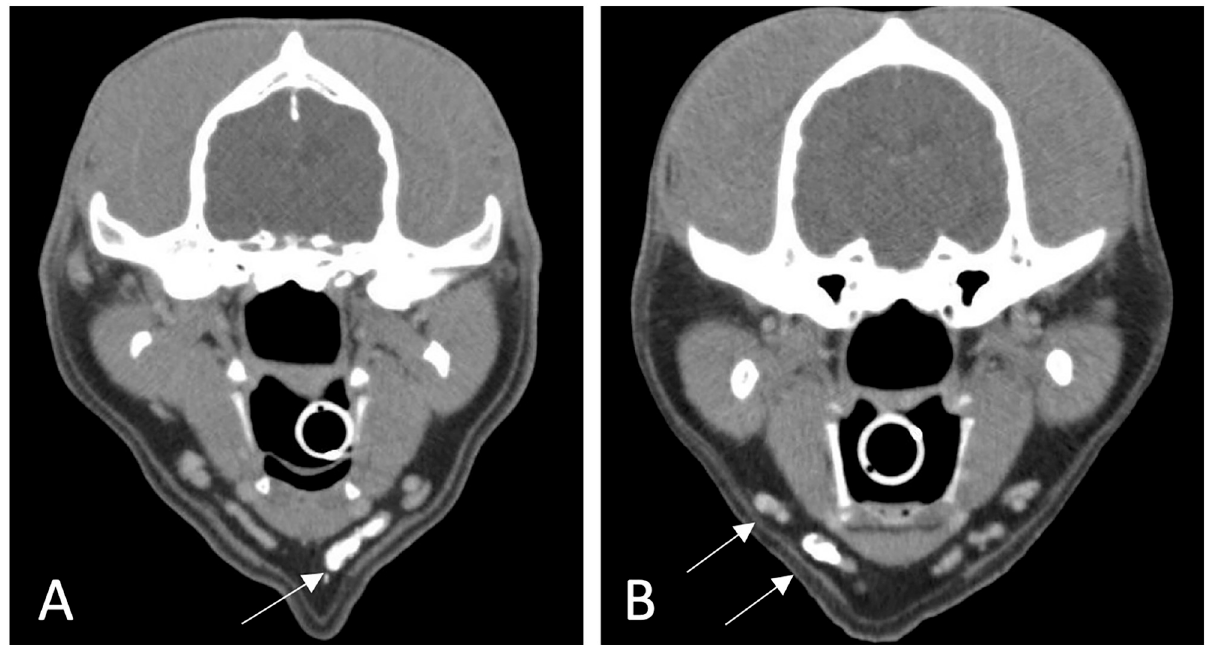
Fig 5. Sentinel lymph node (SLN) detection on indirect computed tomography lymphangiography (ICTL). Representative axial CT images (Soft tissue algorithm: W: 400 HU, L: 40 HU) demonstrating A : Concordance between all reviewers in identification of the left medial mandibular lymph node (MLN) as the SLN (arrow) and B : Discordance between reviewers, in which the medial MLN was the SLN (N = 2) or both the medial and lateral MLN (arrows) were identified as the SLNs (N = 1).